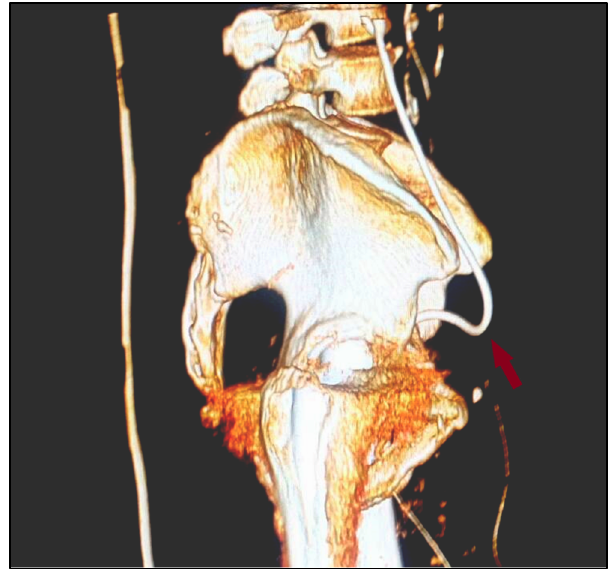
Figure 3. 3D reconstruction of the postoperative pelvic CT scan with urography. Right-lateral view of the bulged inferior 1/3 of the ureter (red arrow) towards the inguinal canal.